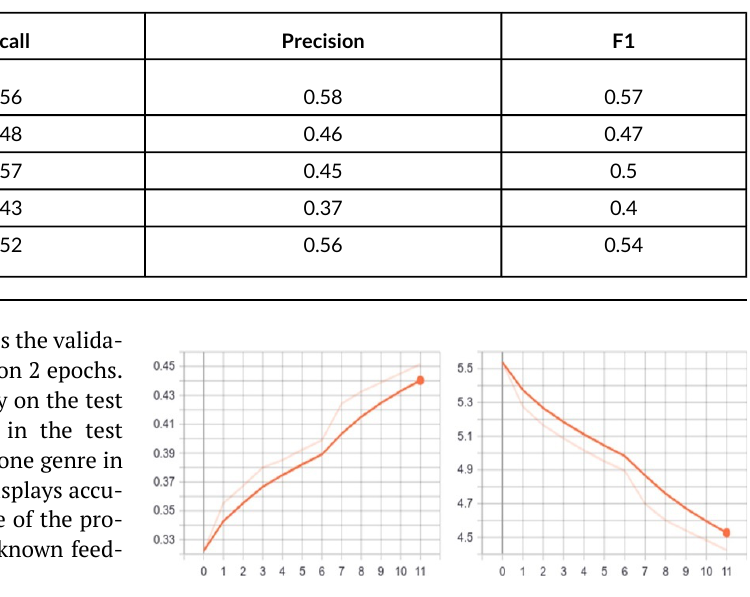
Figure 7. Plots for training data are depicted for accuracy (left) and in for loss